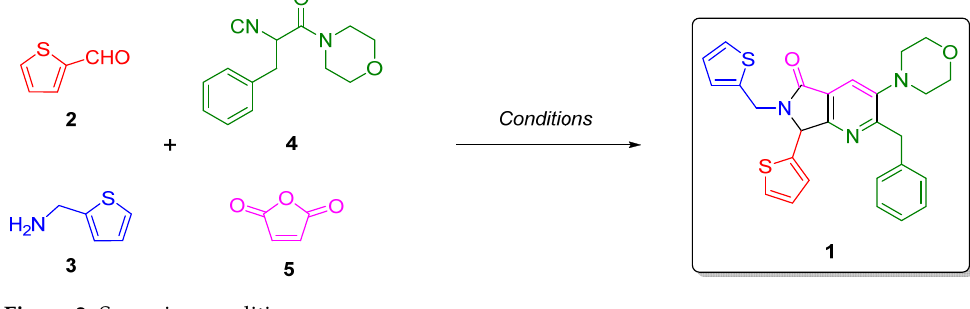
Figure 2. Screening conditions.